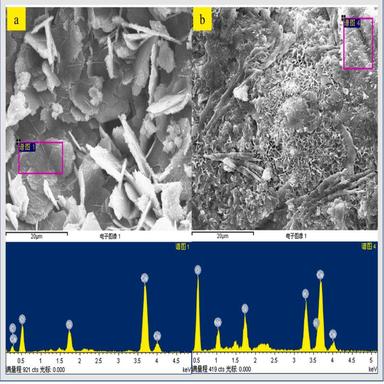
EDS analysis spectrum: (a) Crystal subsequent hydration products; (b) Amorphous subsequent hydration products.